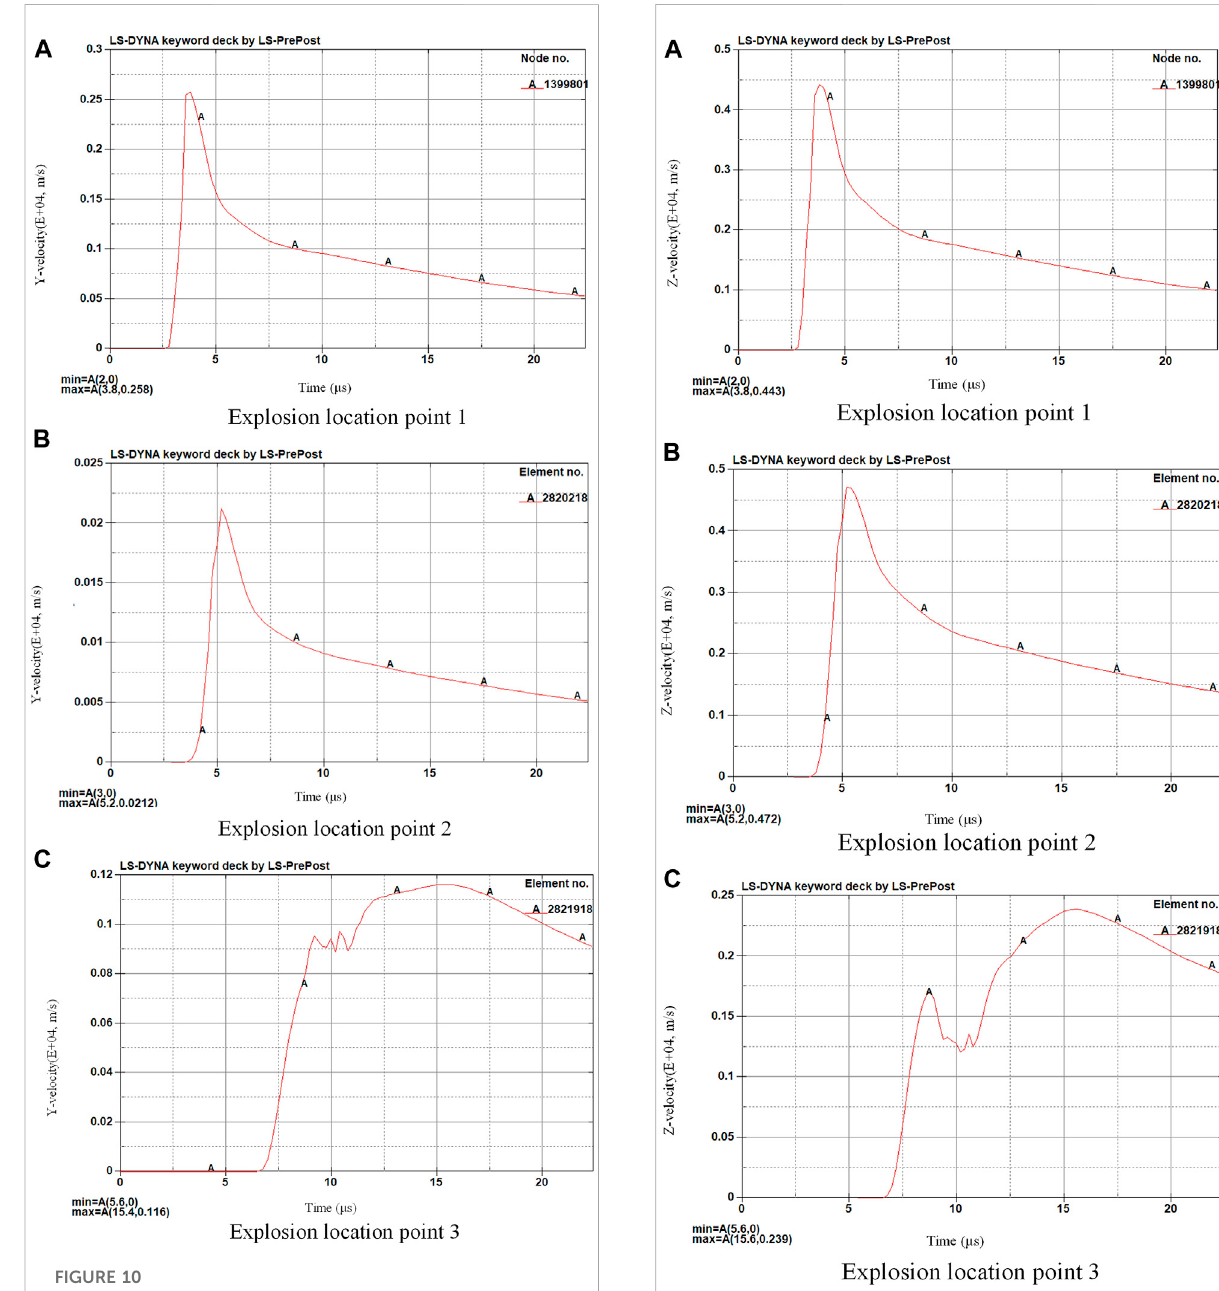
FIGURE 10 Y-direction speed of the measuring point in front of the UAV fuel tank structure. (A) Explosion location point 1. (B) Explosion location point 2. (C) Explosion location point 3.